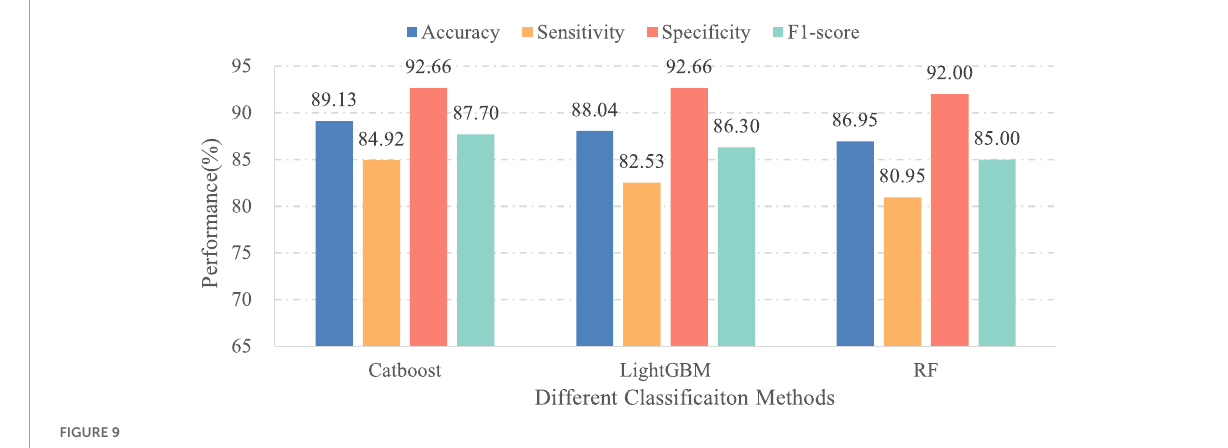
FIGURE9 Performances of different classifiers over independent final testing set.